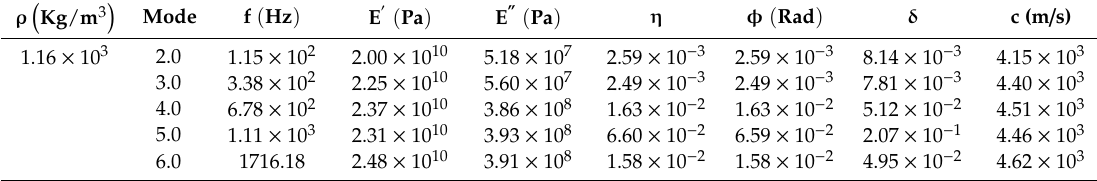
Table 3. Average values obtained for CFRE prepreg plates processed by vacuum